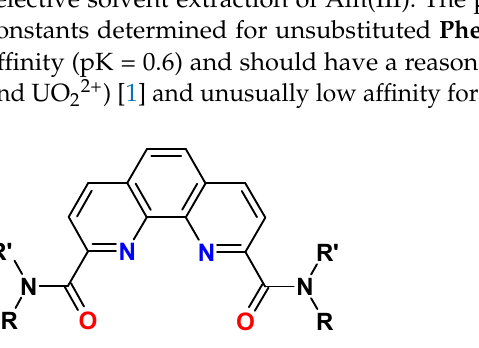
Figure 6. 1,10-phenanthroline-2,9-dicarboxylic acid diamides ( PhenDA ).